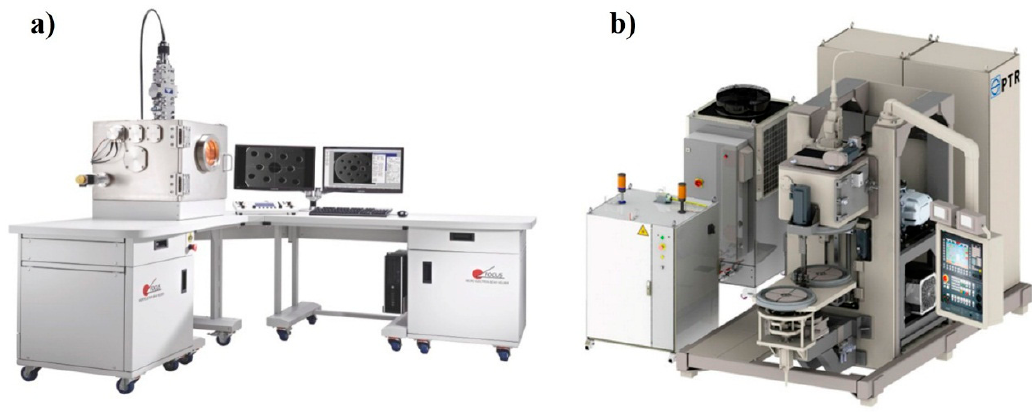
Figure 3. The systematic equipment of laser welding under vacuum ( a ) LAVA-L95. Reproduced with permission from [45], FOCUS electronics GmbH, 2017. ( b ) LASVAC PL 01. Reproduced with permission from [47], PTR Strahltechnik GmbH, 2017.